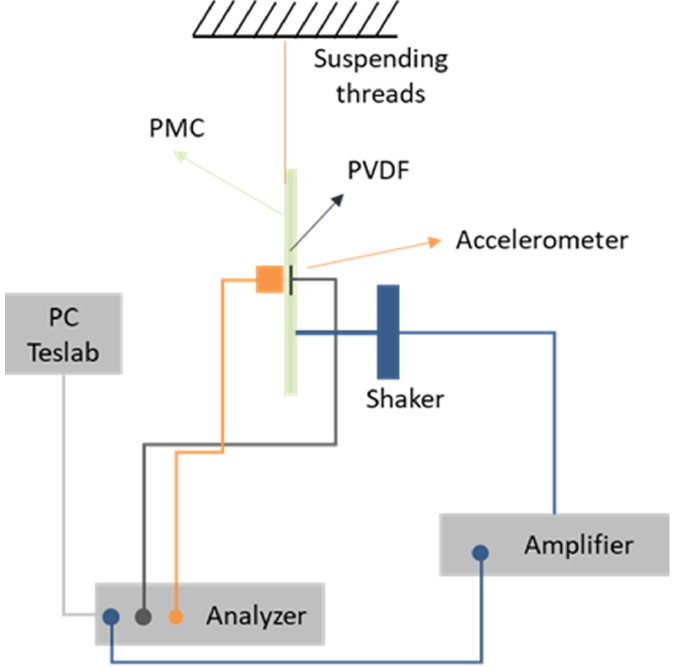
Figure 5. Schematic of the setup used for nonlinear vibration analysis.